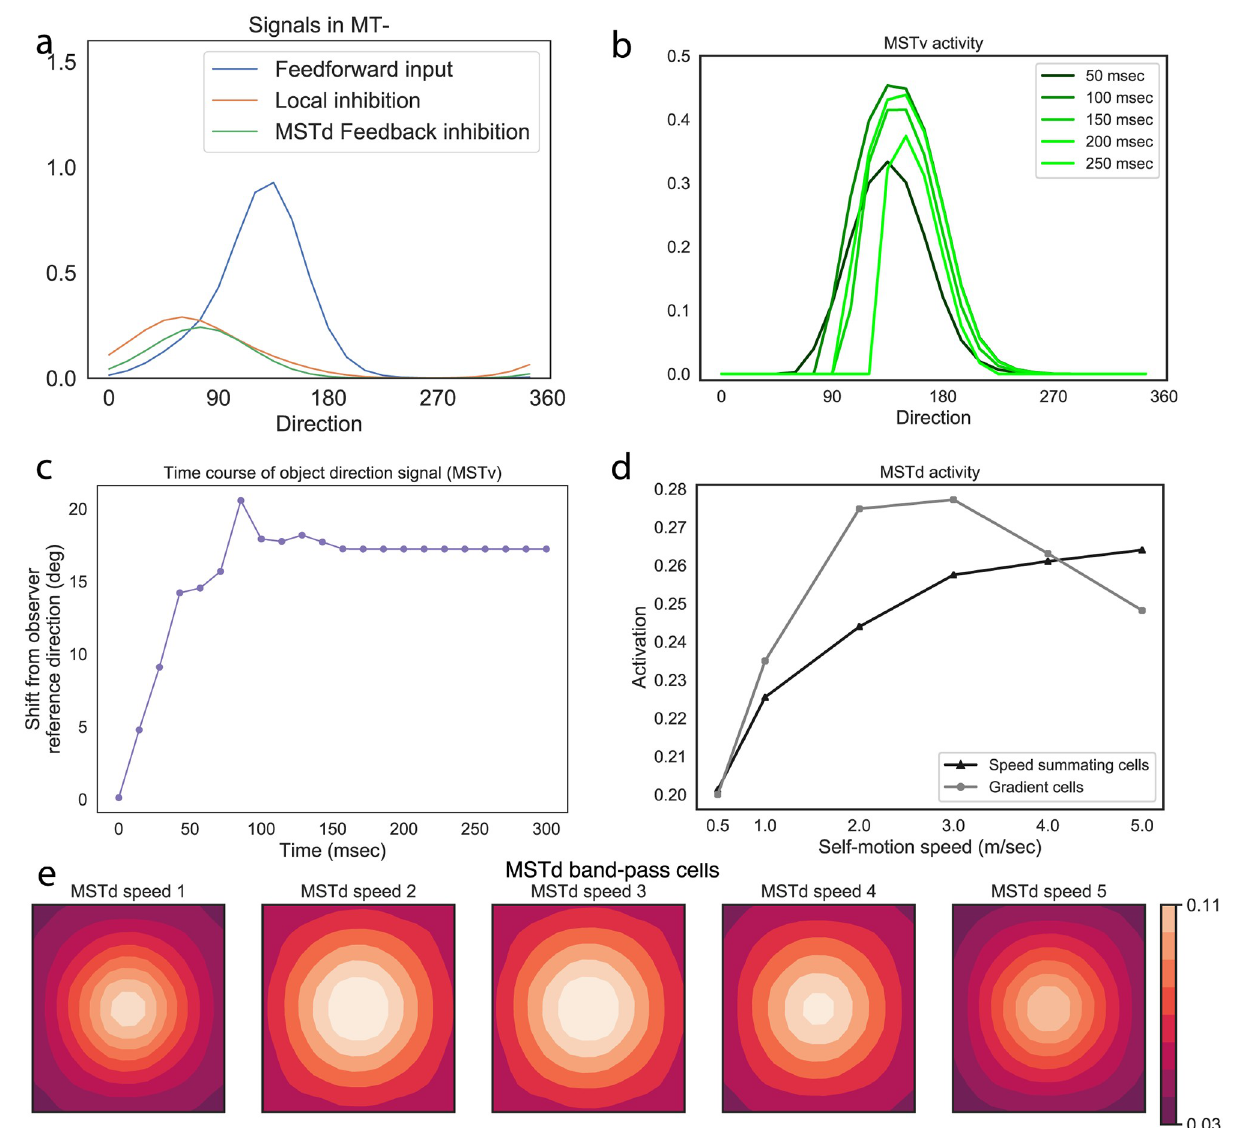
Fig 6. (a) Object motion signals in MT − during fronotoparallel plane simulation. Blue is the object motion signal in MT − , green is the inhibitory feedback signal from MSTd, red is the surround (local) inhibition within MT − . y-axis is activation, x-axis is direction (0-360 deg in 15 deg increments). (b) Shift in the MSTv activity distribution over time ( MT − demonstrates a qualitatively similar evolution). (c) Time course of object motion direction represented by area MSTv units. A zero shift value indicates object motion in a observer-relative reference; positive values indicate shifts in the world- relative direction. Self-motion speed is 1 m/sec and object motion speed is 6˚/s. (d) Activation of the most active gradient (gray) and speed summating (black) MSTd cells for the different self-motion speeds from the Experiment 1 frontoparallel plane stimuli. (e) MSTd band-pass cell activity that reflects an estimate of observer’s self-motion direction. The x and y axes correspond to the spatial coordinates of the optic flow. The overall activation is weak and variance in the distribution is high, indicating uncertainty in the self-motion